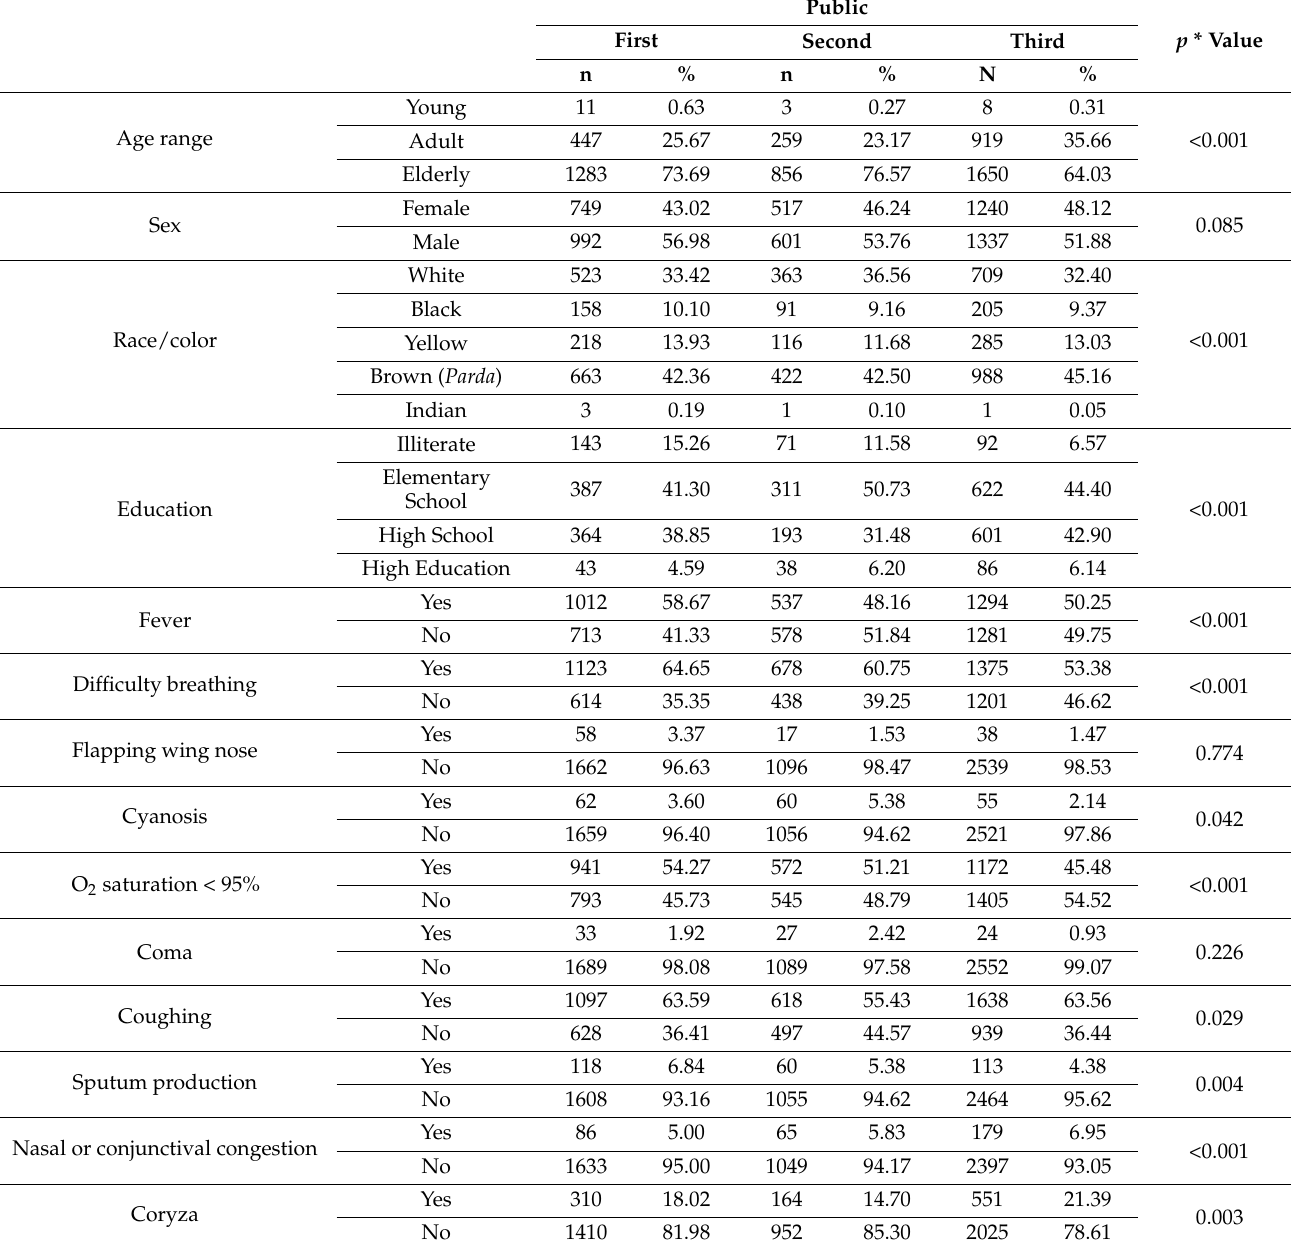
Table 1. Distribution of the waves of incidence of deaths according to socio-clinical variables for patients admitted to public hospital. April 2020 to August 2021, Esp í rito Santo, Brazil.